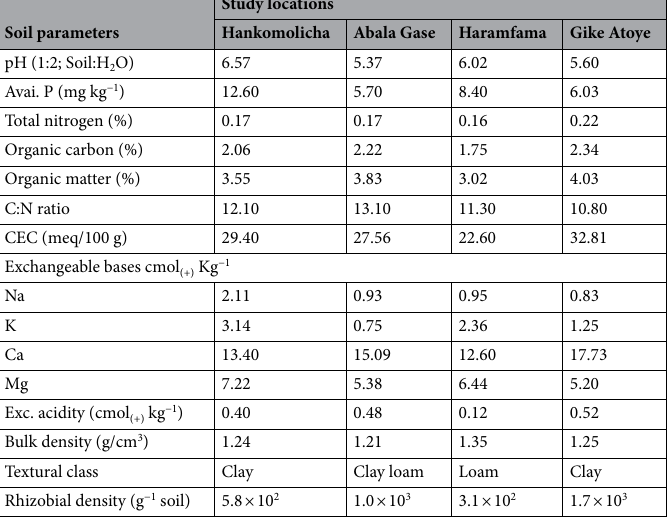
Table 2. Physical and chemical properties of surface soils (0–20 cm) and rhizobia populations at the dilutions were then made from 10 –1 to finally achieve 10 –10 , and subsequently used to inoculate faba bean seed- lings grown on sterilized sand using four replications. Distilled water alternated with N free nutrient solution was used to water the plants. Nodule observations were made after 45 days of inoculation. The enumeration of native rhizobia most-probable-number (MPN) method 31 revealed that the mean populations of native faba bean nodulating rhizobia at the experimental sites (Table 2) varied from 3.1 × 10 2 to 1.7 × 10 3 cells per gram of soil. The highest soil native rhizobial population was observed at Gike Atoye followed by at Abala Gase experimental site. Treatments and experimental design. The study included both greenhouse and field experiments. Six were used for the study. The inoculum was used at the concentration of approximately 10 9 cells g −1 in peat carrier. Purity of strain cultures was assessed in the Soil Microbiology Laboratory at Holleta Agricultural Research and Haremaya University. Sterility of the carrier was checked before mixing with the rhizobial culture. Seeds of three Greenhouse experiment. Treatments comprised a factorial combination of six rhizobium strains for each treatment (strain × variety) arranged in a completely randomized design (CRD). Seed inoculation was done just before planting. Uniform seeds of good viability were surface sterilized with ethanol and hydrogen peroxide 32 before apply- ing carrier-based inoculants. Two healthy seeds inoculated with the required stain were sown per pot at 4 cm depth and later thinned to one after seedling emergence. Parts of non-inoculated seedlings grown in jars were supplied with nitrogen while others were grown without nitrogen as positive (+ N) and negative (−N) control treatments, respectively 32 . Both inoculated and non-inoculted –N control plants were supplied with nitrogen- free nutrient solution 33 . Plants were grown in a greenhouse with average day and night temperature of 28 °C and 18 °C, respectively and harvested 60 days after planting 34,35 . The experimental pots were excessively irrigated at harvest to uproot the plants with minimum disturbance of intact nodules. The roots were then carefully washed to remove sand particles after which nodules were removed and counted. Nodules from each plant were put in pre-labeled separate paper envelope and oven dry at 70 °C for 48 h, and weighted on sensitive balance. Field experiments. A split-plot in a randomized complete block design (RCBD) was used with four rep- licates nested at four different locations. Main plot treatments consisted of six rhizobium strains (NSFBR-12, Dosha and Gora). Land preparation was done following conventional practices to make the field suitable for planting and divided into blocks and further into individual plots. Plot sizes measured 4 × 4 m (16 m 2 ). Each variety was